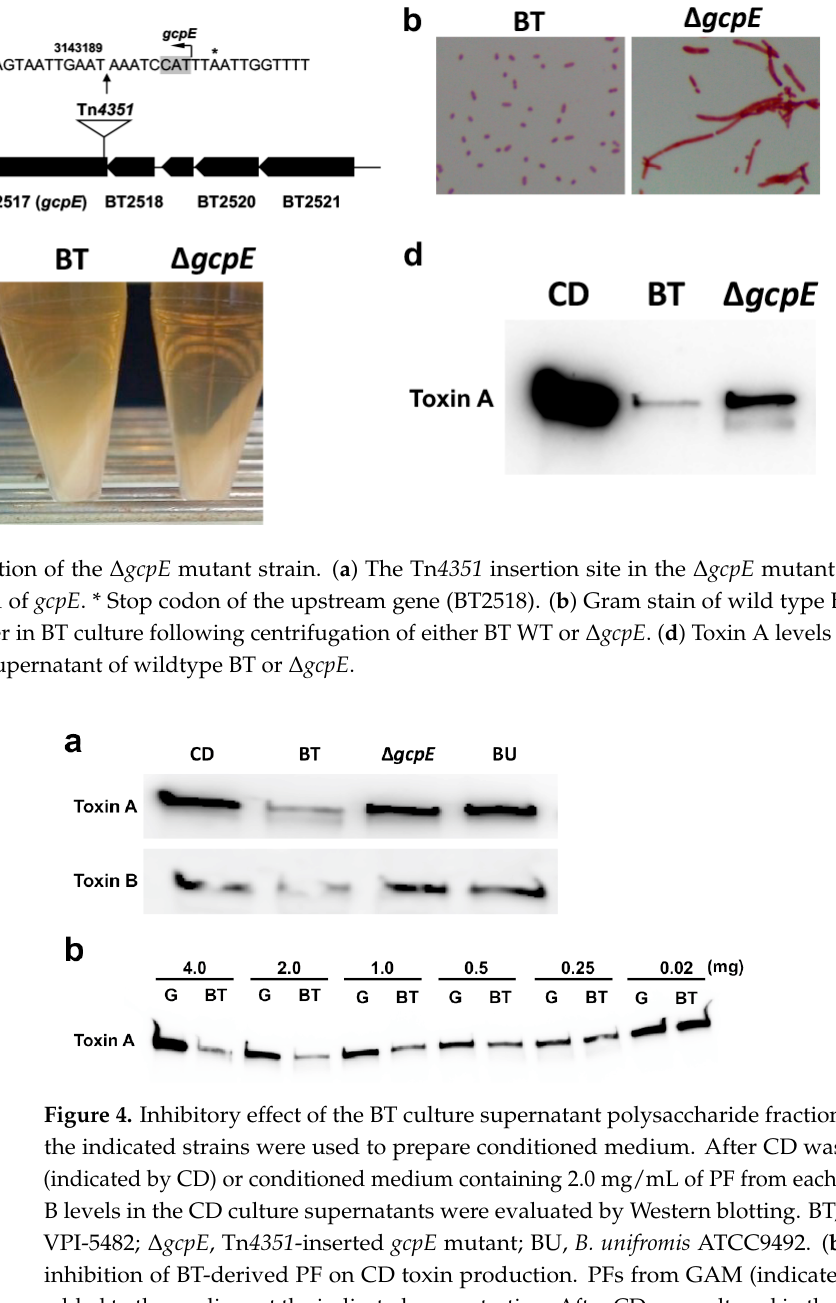
Figure 4. Inhibitory effect of the BT culture supernatant polysaccharide fraction (PF). (a) PFs from the indicated strains were used to prepare conditioned medium. After CD was cultured in GAM (indicated by CD) or conditioned medium containing 2.0 mg/mL of PF from each strain, toxin A and B levels in the CD culture supernatants were evaluated by Western blotting. BT, B. thetaiota- omicron VPI-5482; Δ gcpE , Tn 4351 -inserted gcpE mutant; BU, B. unifromis ATCC9492. (b) Dose-de- pendent inhibition of BT-derived PF on CD toxin production. PFs from GAM (indicated by G) or